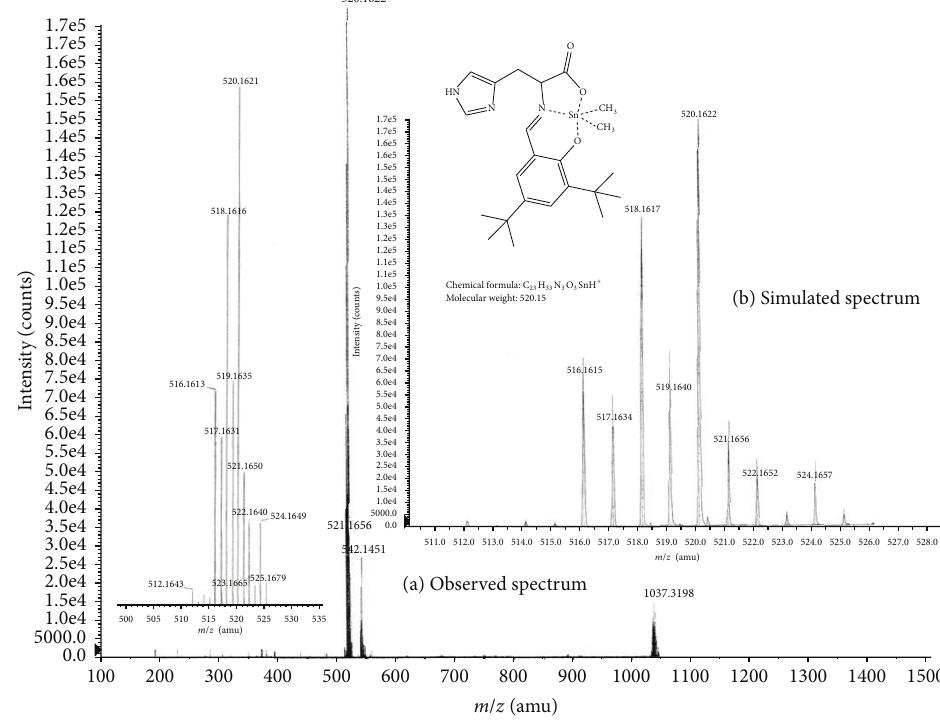
Figure 2: Observed mass spectrum (a) and simulated spectrum (b) of complex 1 .